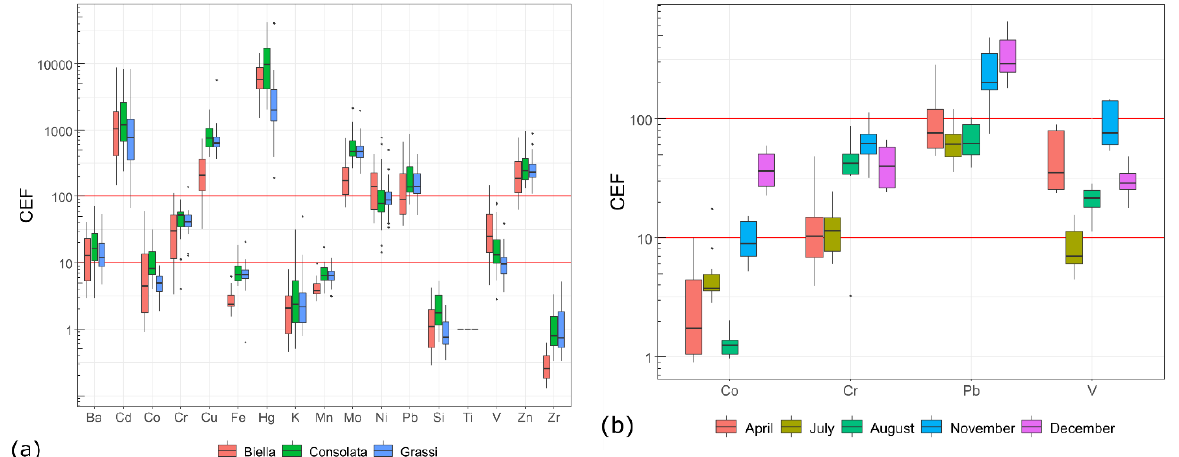
Figure 4. Crustal enrichment factors for PM 10 samples collected during 2007; ( a ) CEF values sorted according to the sampling site; ( b ) CEF values sorted according to the month of sampling for the samples collected at Biella site.